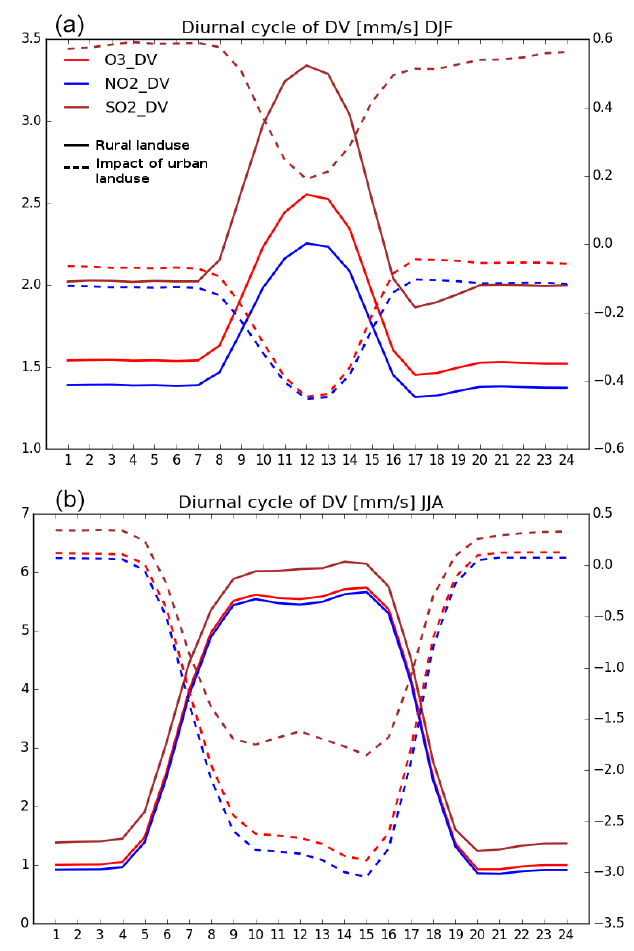
Figure 11. The diurnal cycle of the rural deposition velocities (DV; solid lines; left y axis) and the impact of urbanization (dashed lines; right y axis) for 2015–2016 DJF (a) and JJA (b) for NO 2 (blue), SO 2 (brown), and O 3 (red) (mms − 1